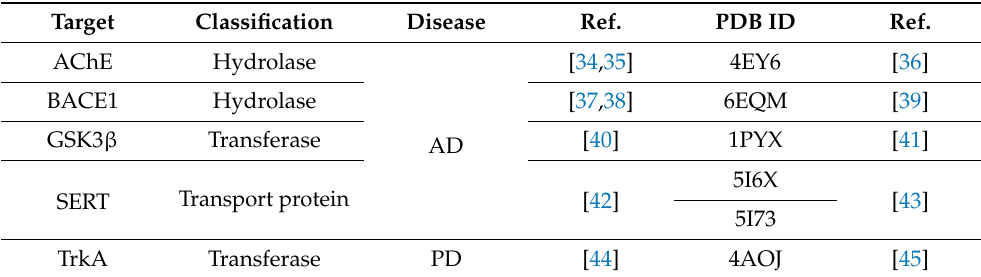
Table 1. The list of the studied target